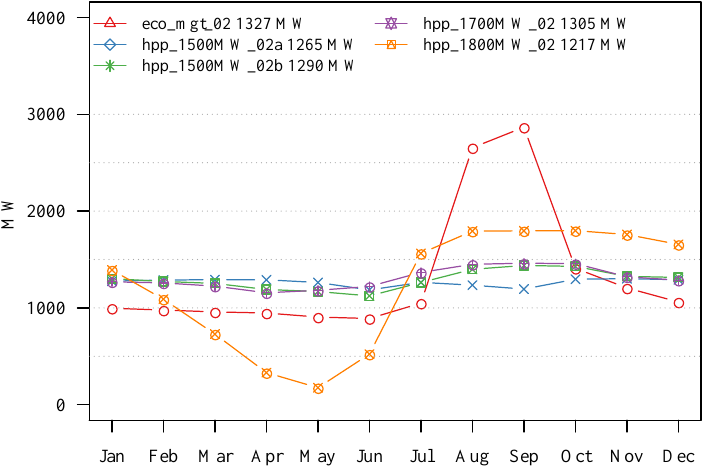
Figure 9. Average hydropower production during 1961–1999 with medium seepage